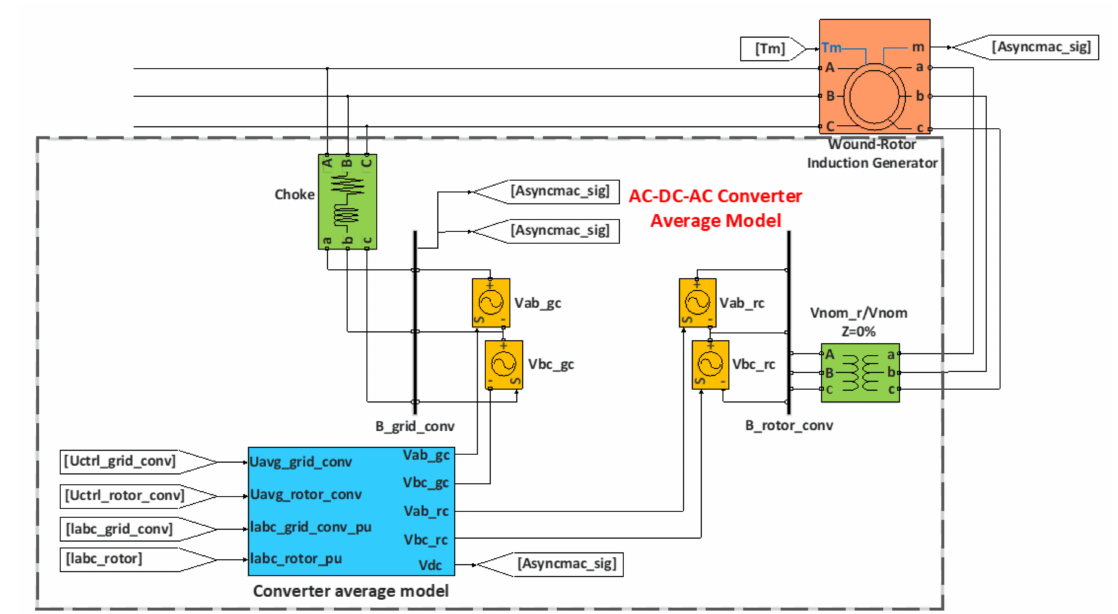
Figure 10. Block diagram of a state-average PWM converter model. In this figure, the parameters Uctrl_grid_conv, Uctrl_rotor_conv, Uavg_grid_conv, Uavg_rotor_conv, Iabc_grid_conv_pu, Iabc_rotor_pu, Vab_gc, Vbc_gc, Vab_rc, Vbc_rc, Vdc, and Asyncmac_sig represent the grid-side converter voltage control signal, rotor-side converter voltage control signal, grid-side average converter voltage signal, rotor-side average converter voltage signal, grid converter current signal, rotor converter current signal, grid-side voltage between phases a and b, grid-side voltage between phases b and c, rotor-side voltage between phases a and b, rotor-side voltage between phases b and c, DC-link voltage, and the asynchronous machine signal,